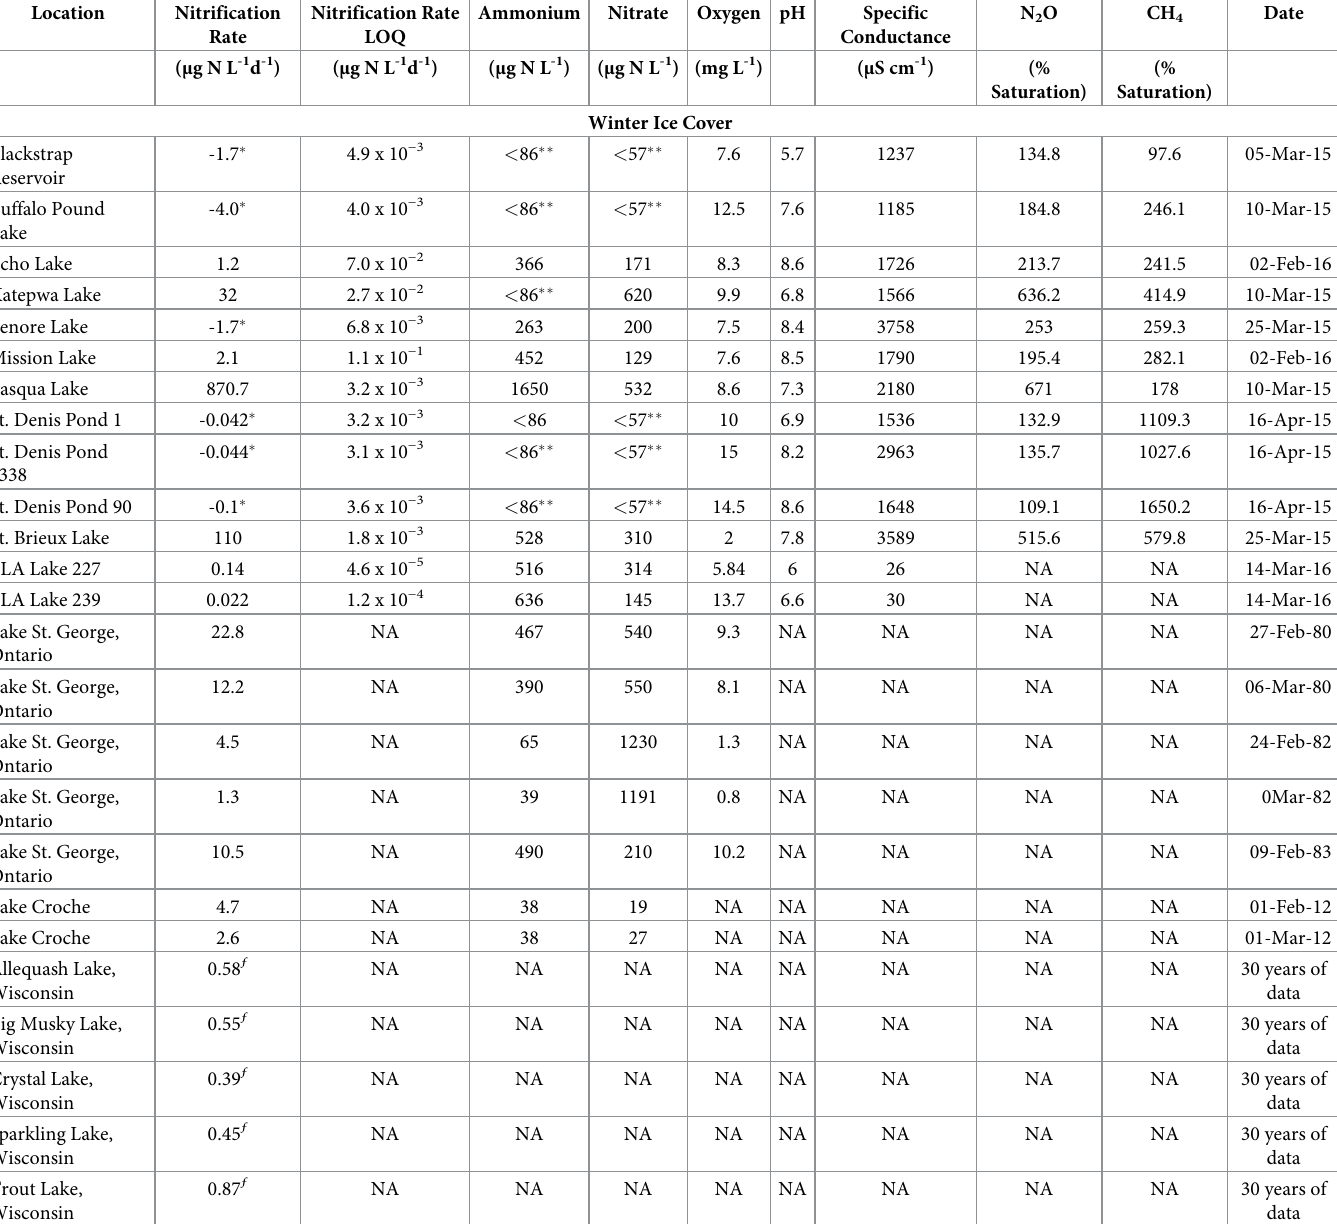
Table 1. Winter nitrification rates and associated data for this study (under ice cover) and for Lake St. George (near surface at 2 m depth, under ice cover; [21]); for surface nitrification rates in Lake Croche (ice-covered; [38]); and for surface estimates of nitrate accumulation in Wisconsin lakes part of the North Temperate Lakes Long-Term Ecological Research (NTL- LTER) study (ice-covered, 30 years of accumulated data; [19]). Values below limits of quantitation (LOQ) for nitrifica- tion rates are reported, including negative values (following [40]) and sample-specific LOQ (as described in Methods and calculated as per [43,44])are reported.